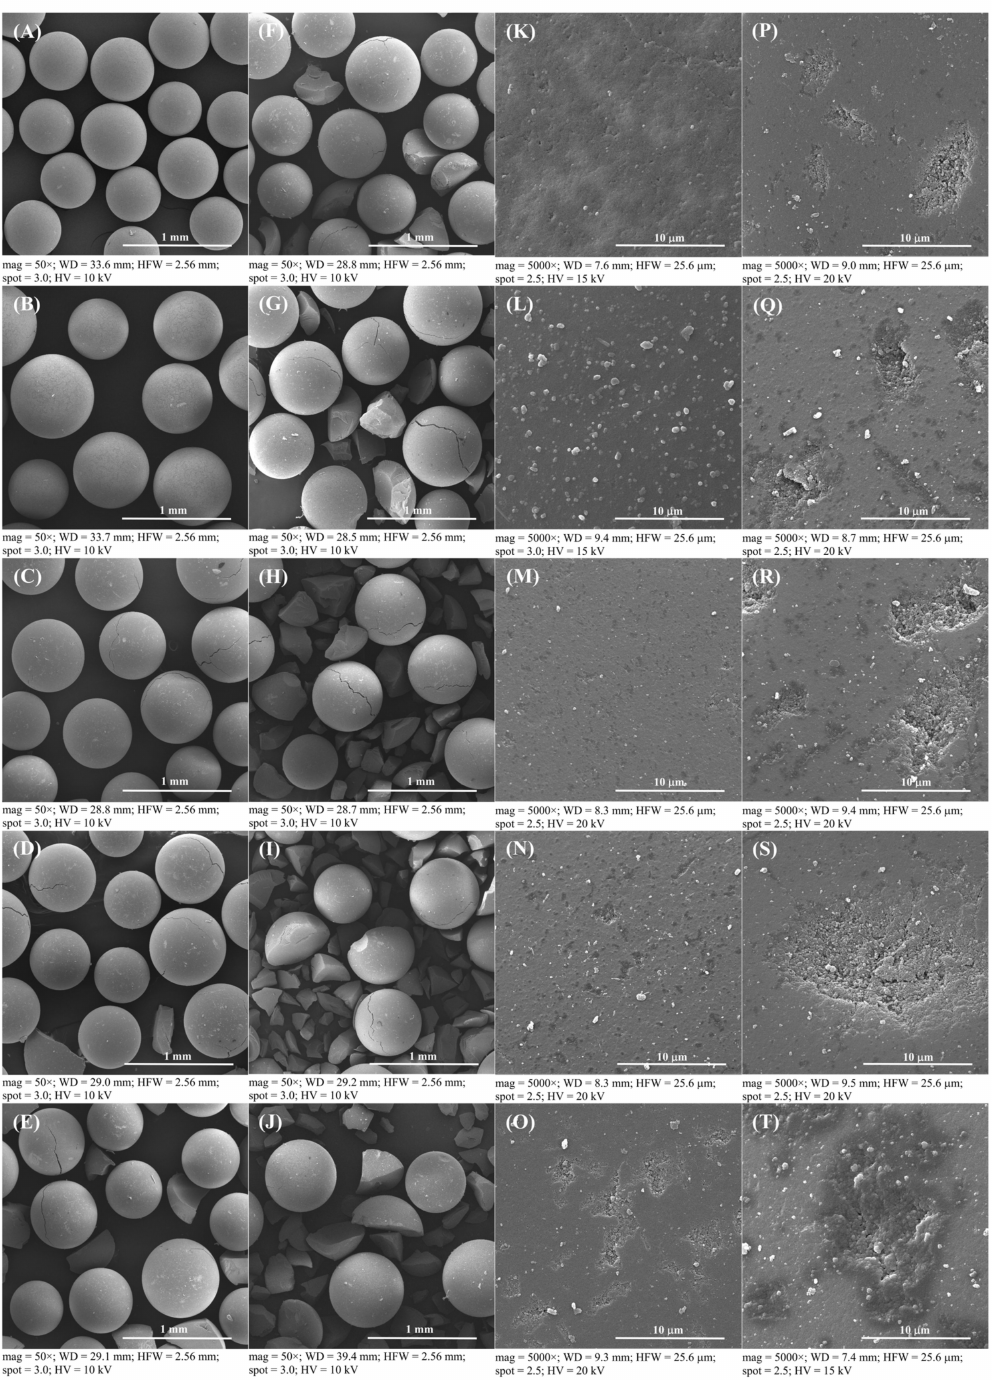
Figure 4. SEM images of the Amberlyst 15 catalyst: ( A ), ( K ) fresh catalyst at 50 and 5000 × magni- fications, respectively; ( B – J ), ( K – T ) recovered catalysts after first to ninth cycles at 50 and 5000 × magnifications,